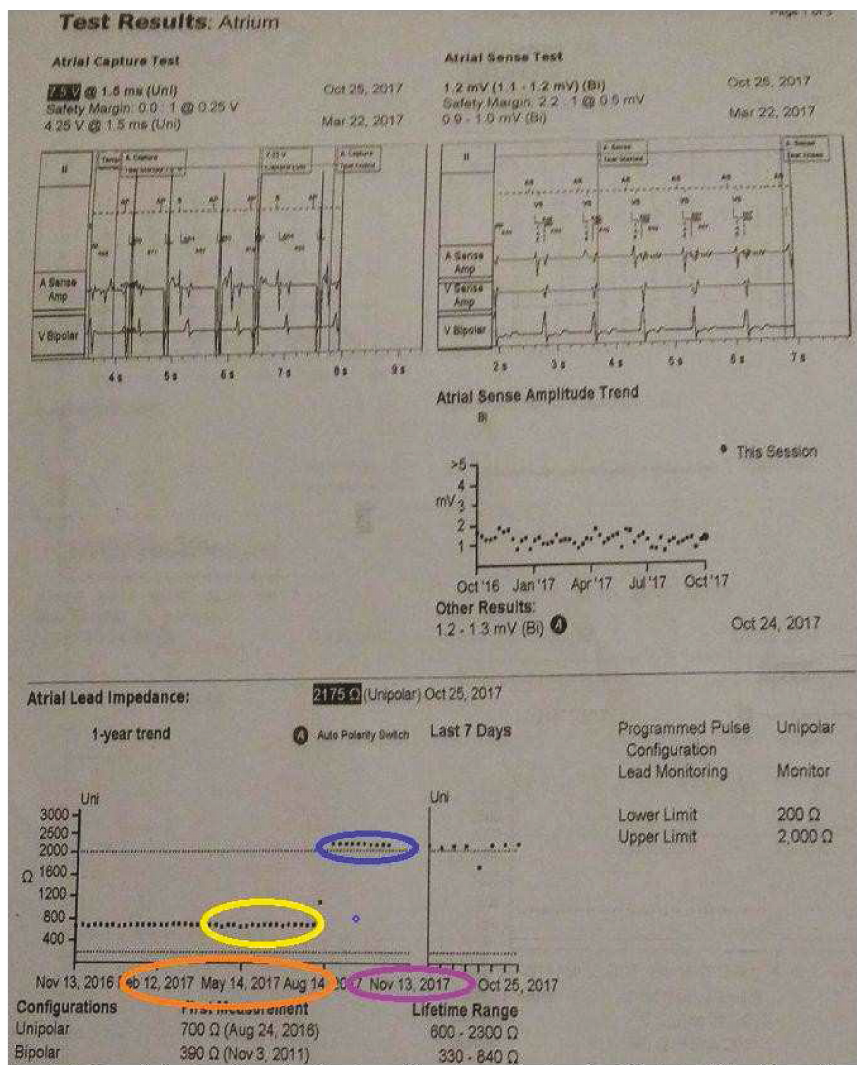
Figure 2: Device evaluation showed loss of atrial capture and sudden increase in lead impedance from normal in May 2017 (yellow circle) to 2000 ohms in August 2017 (blue circle).